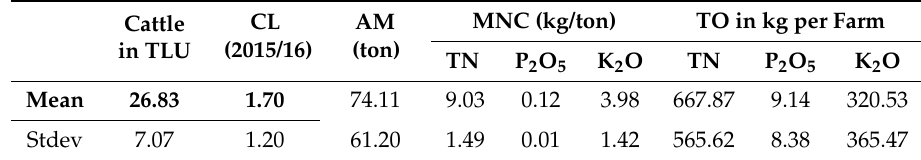
Table 3. Manure production (ton) and nutrient contents (kg/ton) and total outputs in Borana, southern Ethiopia (based on nine